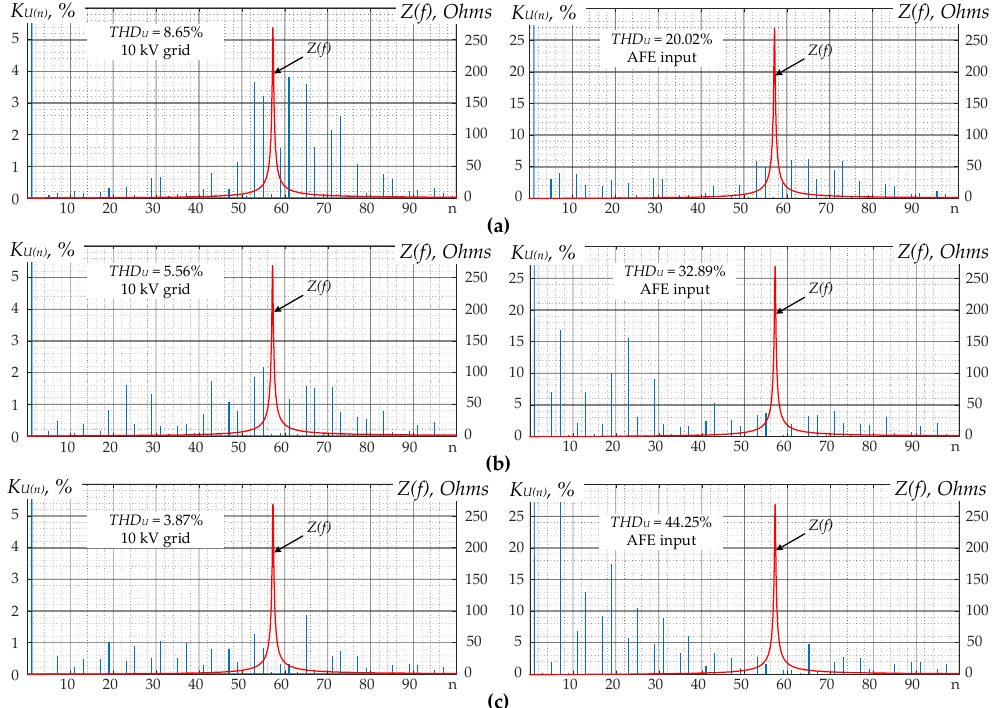
Figure 25. The results of using ( a ) Fixed Pulse Pattern Control; ( b ) SHEPWM (53, 55, 59, 61); ( c ) SHMPWM (47–61) when there is resonance in the medium-frequency region. The medium-frequency resonance is located in the AFE harmonic generation